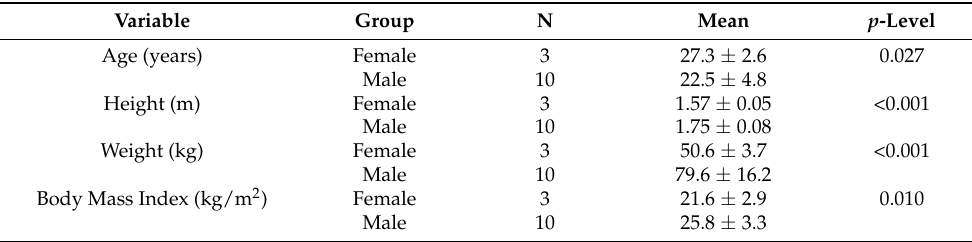
Table 1. Participant anthropometric